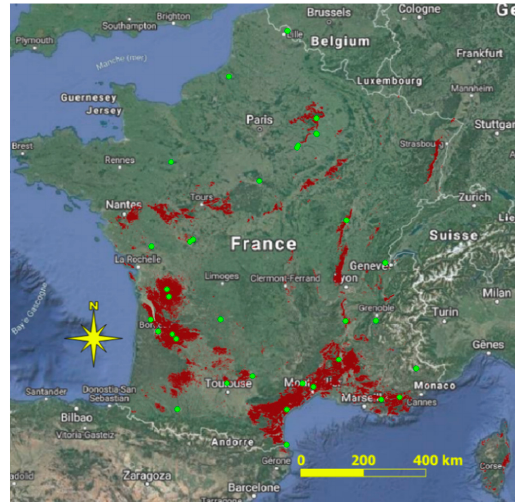
Figure 4. Locations of the observations of Vitis vinifera L. in France (in green, source: iNaturalist) and the grapevine crops declared in 2018 (in red). and the grapevine crops declared in 2018 (in